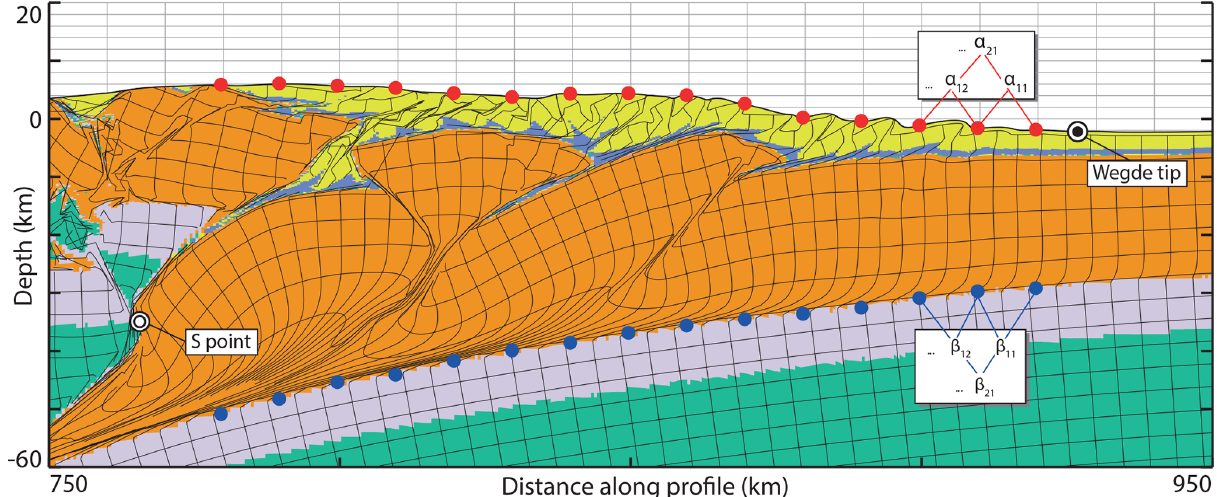
Figure 6. Example of α and β sampling routine. S point: internal limit of the wedge considered for critical-taper analysis, located at the tip of the lower-crustal indenter of the overriding plate. Wedge tip: the outer tip of the wedge considered for critical-taper analysis, located at the tip of the orogenic deformation zone. Red dots: elevation sampling points along the wedge for a given sampling interval. For each sampling interval, α is first calculated for every adjacent point (e.g., α 11 , α 12 ) before we calculate the mean ( α 1 ) of these local, individual α values for the entire wedge. The process is then repeated for all sampling intervals (e.g., α 21 ). Blue dots: depth sampling points along the wedge for a given sampling interval. β is calculated in the same manner as α (described